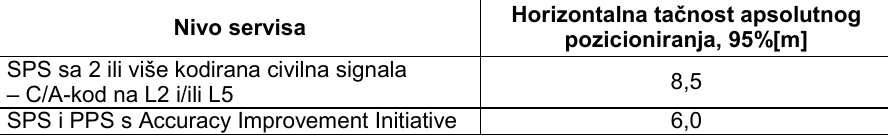
SPS i PPS s Accuracy Improvement